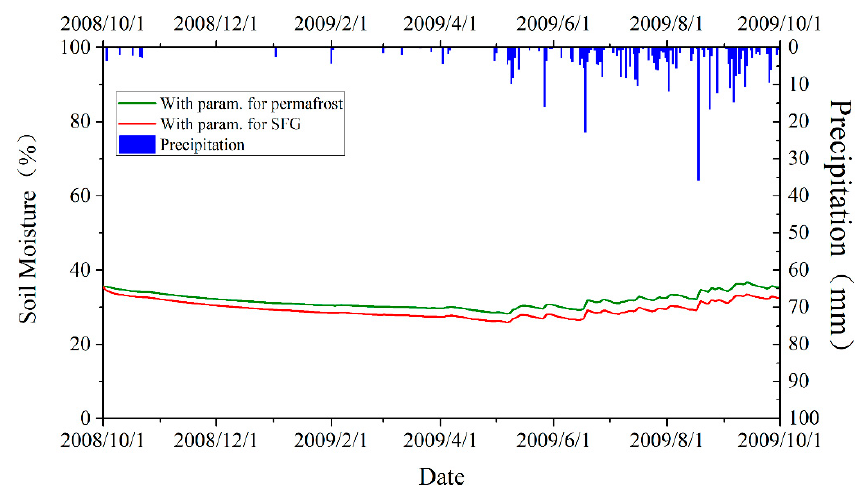
Figure 8. Simulated soil moisture using the parameters calibrated for the permafrost area and for the SFG area.